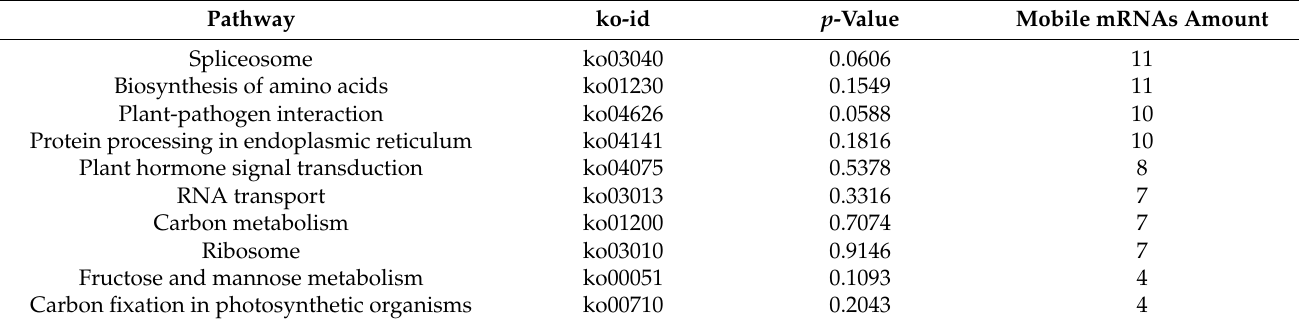
Table 4. The main pathways of the mobile mRNAs